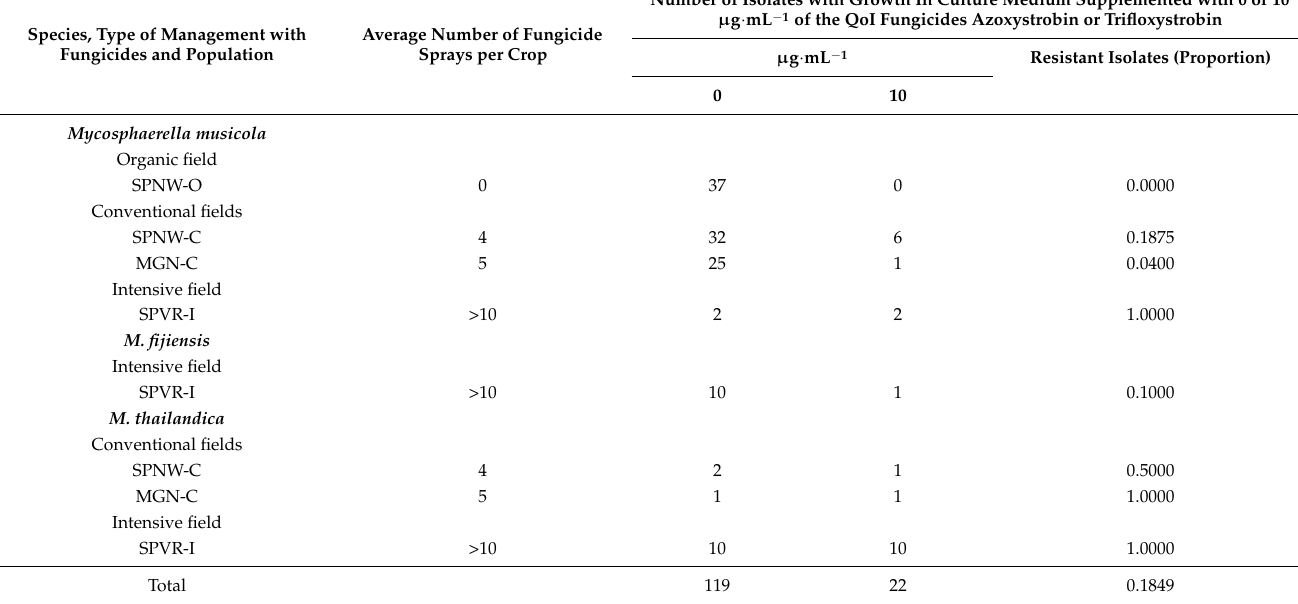
Table 2. Distribution of QoI fungicide resistance in populations of Mycosphaerella musicola , M. fijiensis and M. thailandica sampled from four banana plantations with different fungicide management systems a .